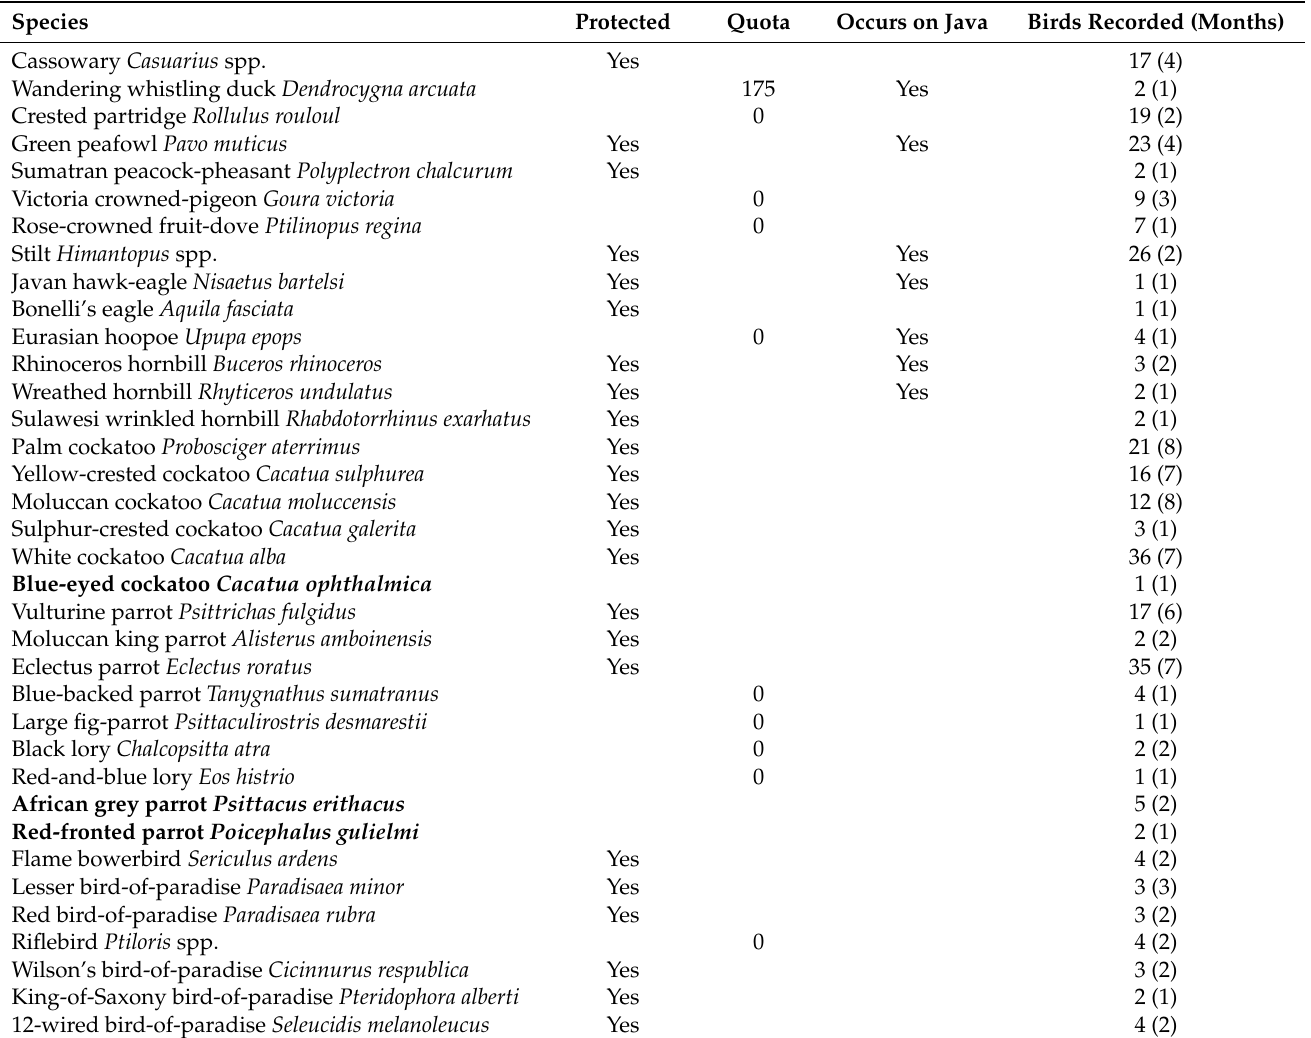
Table 4. One year of advertisements on Instagram from one pet shop based in Java, Indonesia. All species occur in Indonesia, apart from the three indicated in bold. Protected refers to the species being included on Indonesia’s protected species list; Quota refers to the harvest quota for 2020 for non-protected species; Occurs on Java refers to whether the species is native to the main island of Java (excluding